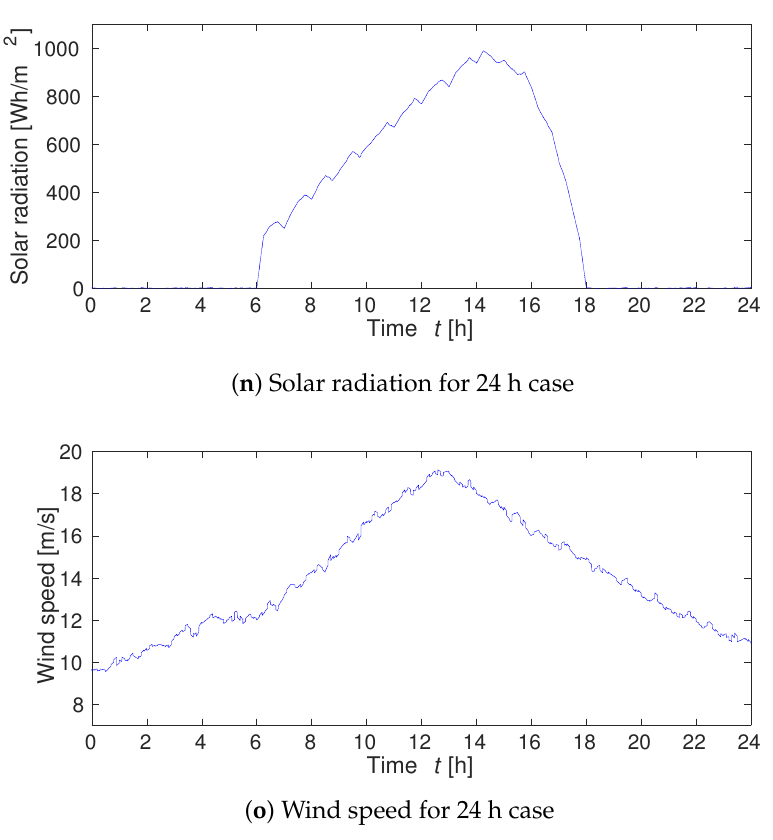
Figure 20. Simulation result for 24 h case (with battery, suppression of renewable energy sources and demand